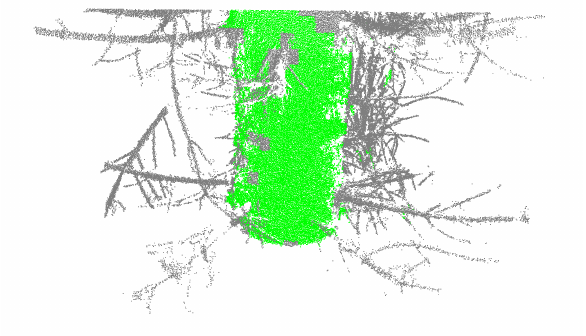
Figure 2. A laser scanned point cloud of part of a tree. The data observations that were classified as stem points by the filter algorithm are coloured green.